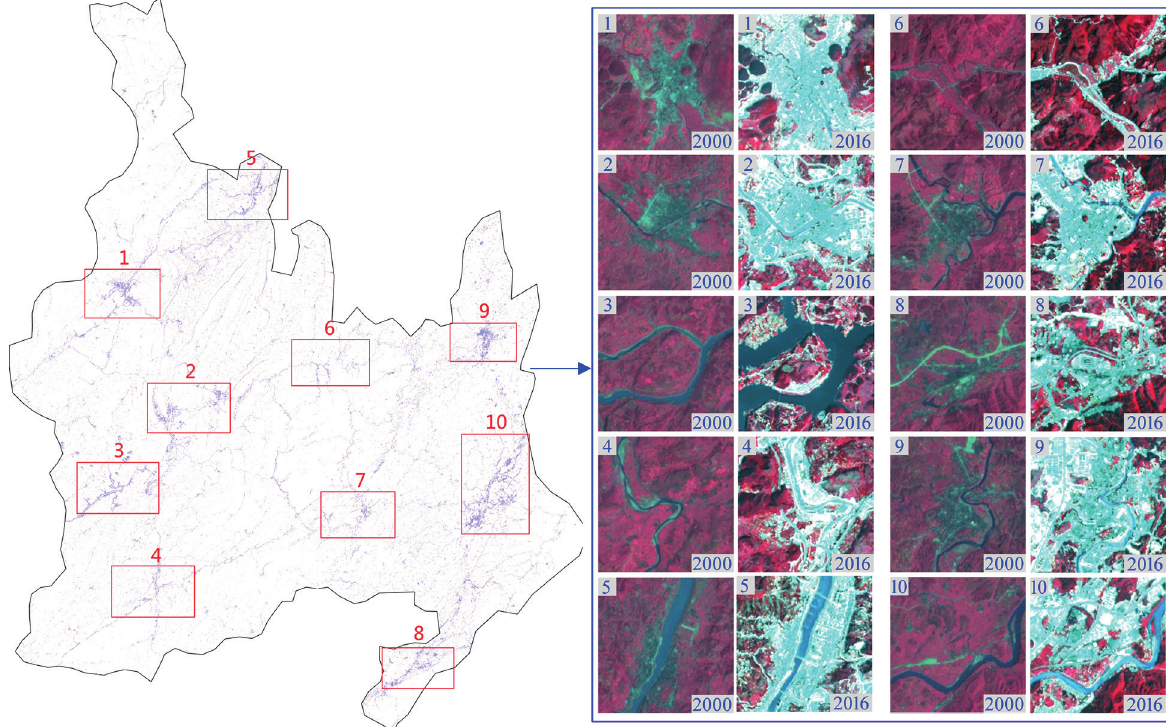
Figure 4 - New additional non-vegetation areas and the part of contrast images of typical regions that was changed from 1 to 10 in 2000 and 2016,